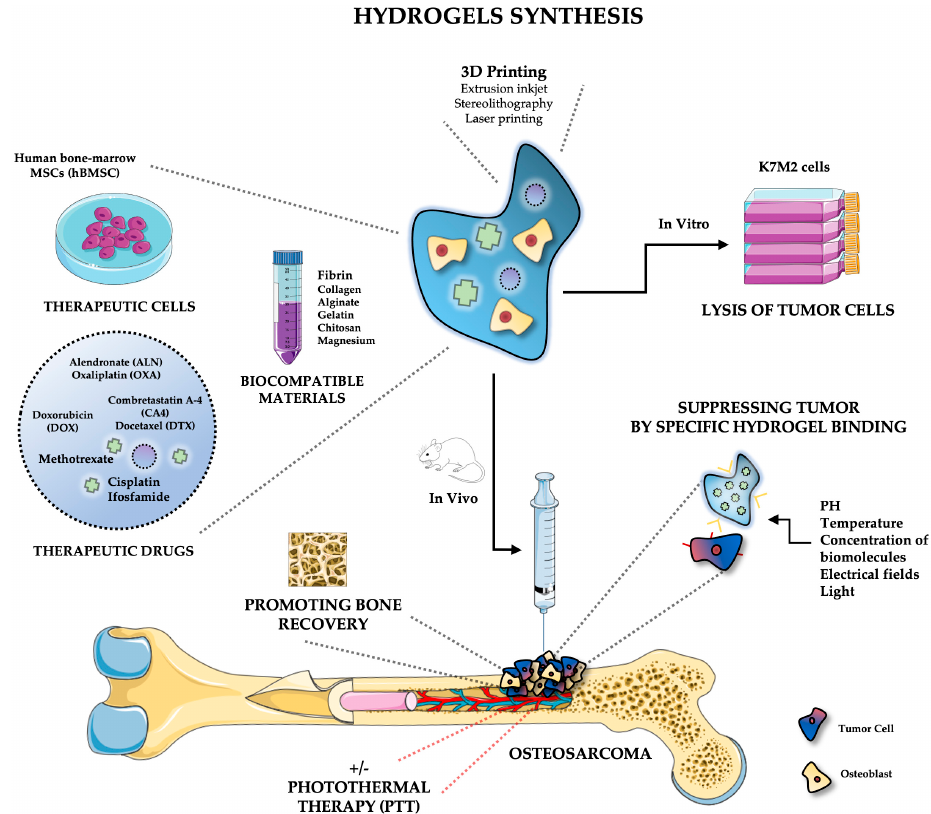
Figure 2. Example schematic of hydrogel fabrication and site-specific incorporation to treat osteosarcoma. Hydrogels may be stimuli-responsive by self-regulation in response to pH, temperature, or mechanical stress. The hydrogels may also include properties that are pro-osteogenic while suppressing or even reducing tumor growth. This figure was generated using the Servier Medical Art.